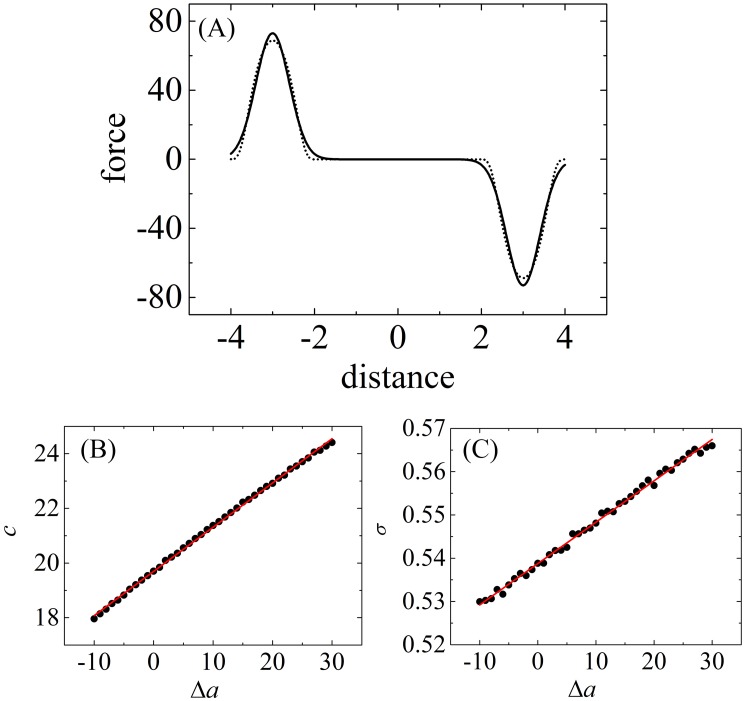
Im-DPD force parameters c and σ obtained from Ex-DPD simulations.(A) Gaussian curve fitting of the repulsive force between a C-type bead and a water slice as a function of distance between the particle and the center of mass of the water slice. Dash line is the simulation data. Solid line is the fitting result. (B) and (C) Linear fittings of c and σ as a function of the repulsive force difference.